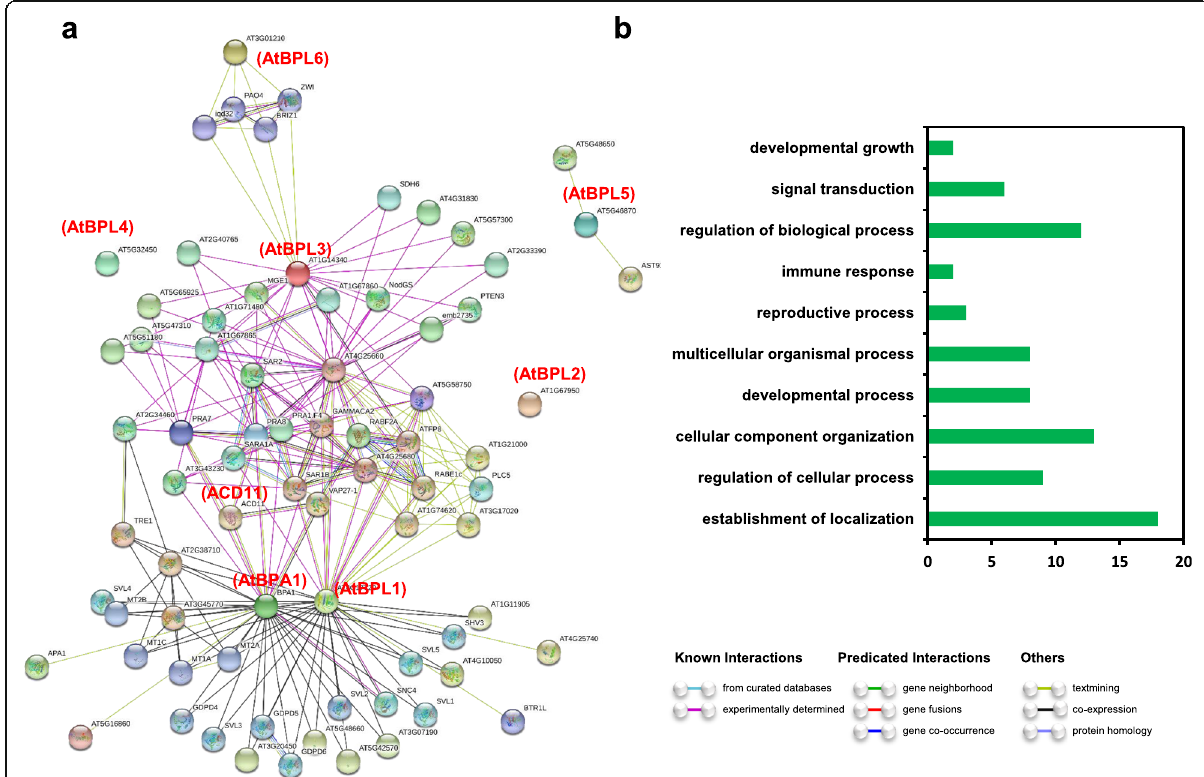
Fig. 5 The protein-protein interaction network of Arabidopsis BPAs. a The protein-protein interaction network of Arabidopsis BPAs. The network was predicted using STRING (https://string-db.org/). There are 77 protein nodes and 297 protein-protein association edges in the network. Green, red, and blue lines indicate interactions predicted from gene neighborhood, fusions, and co-occurrence, respectively. Light green, black, and dark blue lines indicate additional interactions inferred from text mining, co-expression, and protein homology, respectively. b GO annotation of predicted BPA interacting